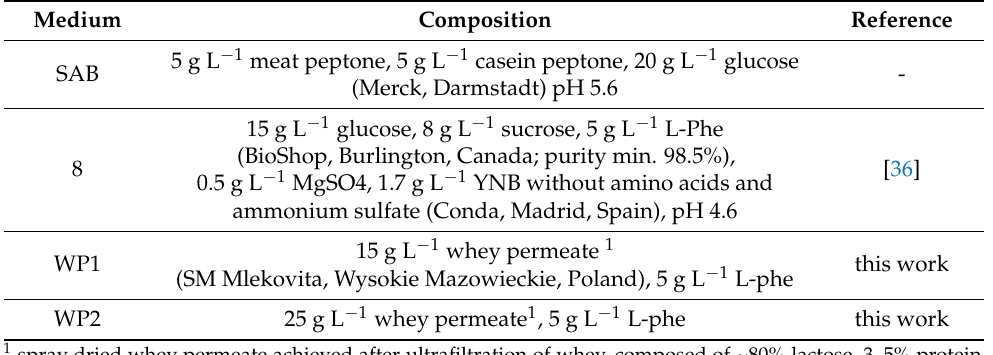
Table 5. Media composition.